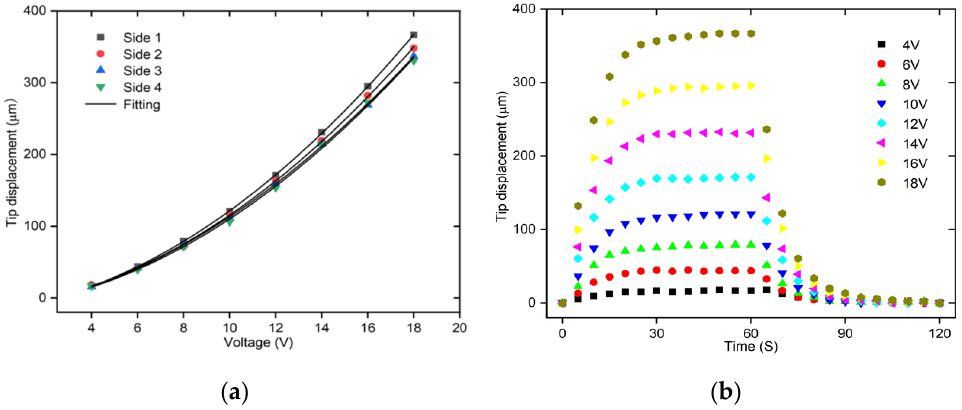
Figure 12. The static and dynamic testing of the 3D U-shaped actuator. ( a )The static displacements vs. voltages of the 3D U-shaped actuator. ( b ) The dynamic testing of different sides of the side 1 of the 3D U-shaped actuator.